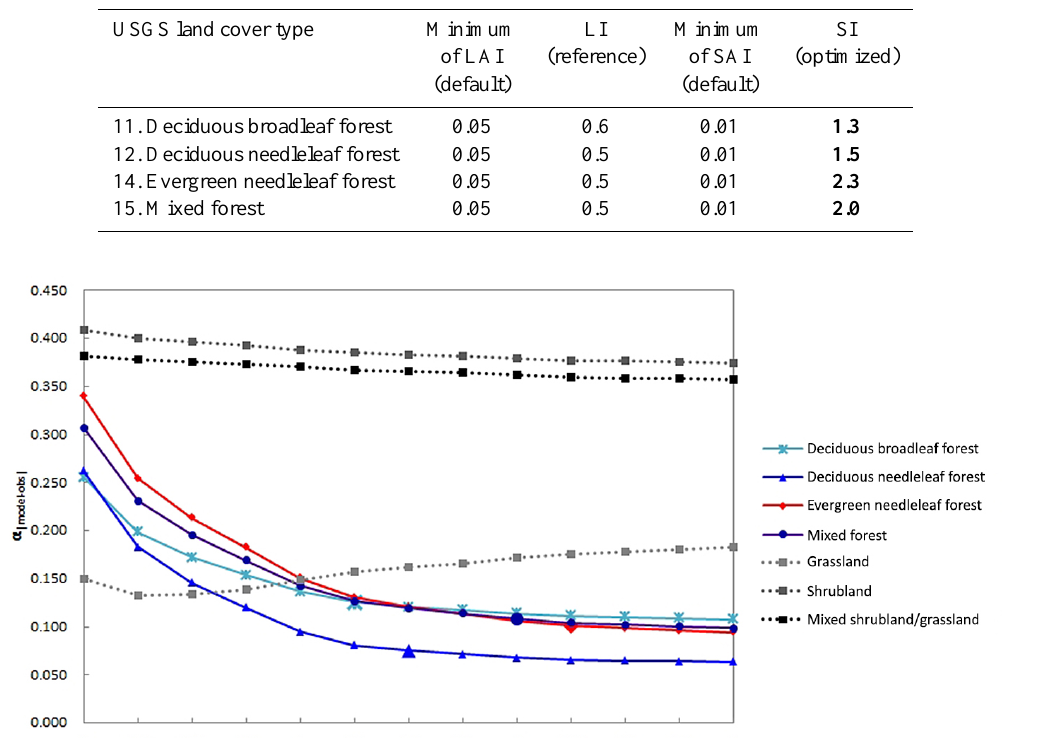
Table 5. Minimum value of LAI, reference values (LI), the default minimum value of SAI, and optimized SI values (in bold) for selected USGS land cover type (forest). The optimized values are based on the sensitivity test.